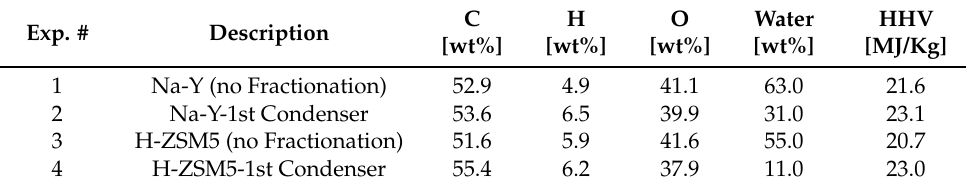
Table 6. Liquid Characteristics for experiments with and without fractionation, dry basis. Exp.